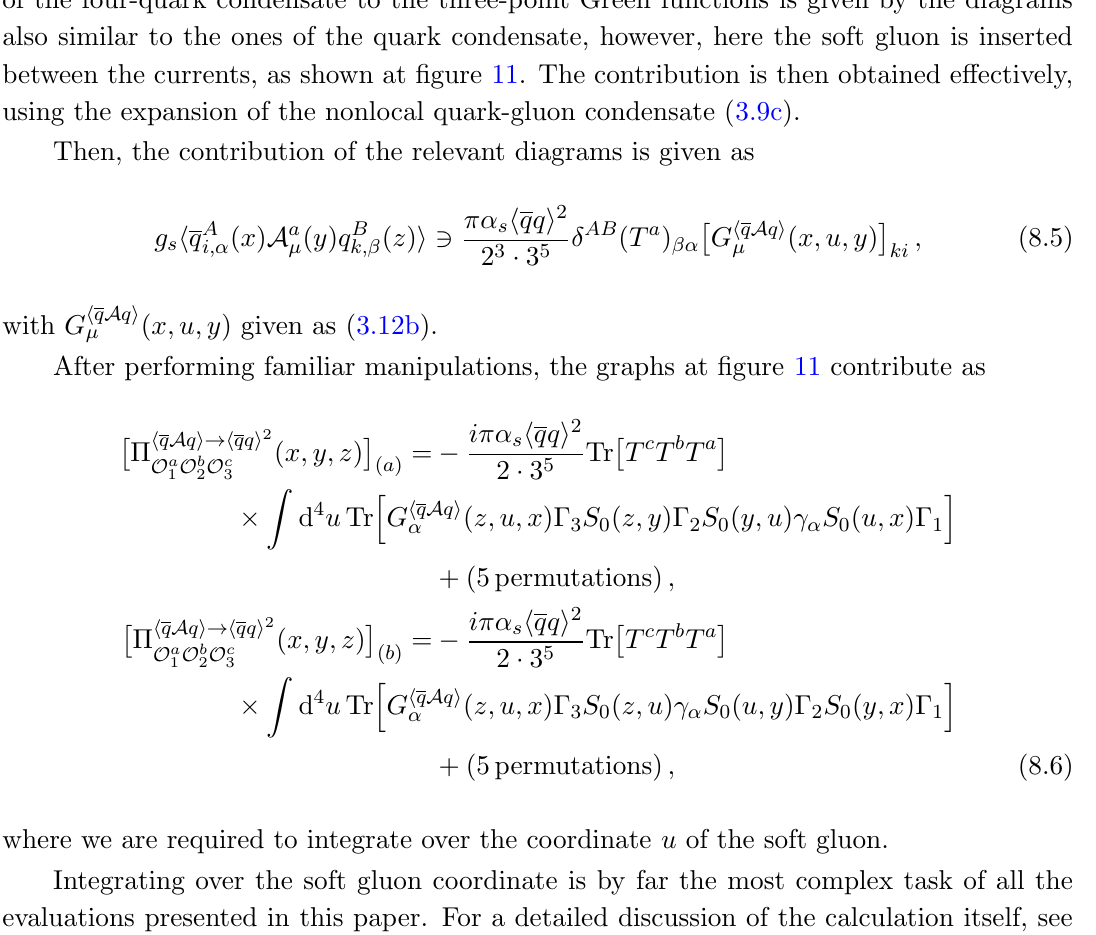
Propagation of nonlocal quark-gluon